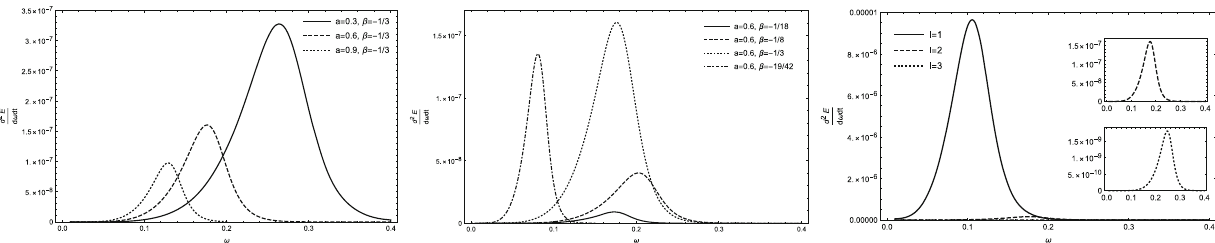
Fig. 10 For β < 0 and M = 1, the left-figure is the power emission The right-figure is the power emission spectra taken l as the variable at a = 0 . 6 and β = − 1 spectra taken a as the variable at β = − 1 , l = 2. The center-figure is 3 the power emission spectra taken β as the variable at a = 0 . 6, l = 2.